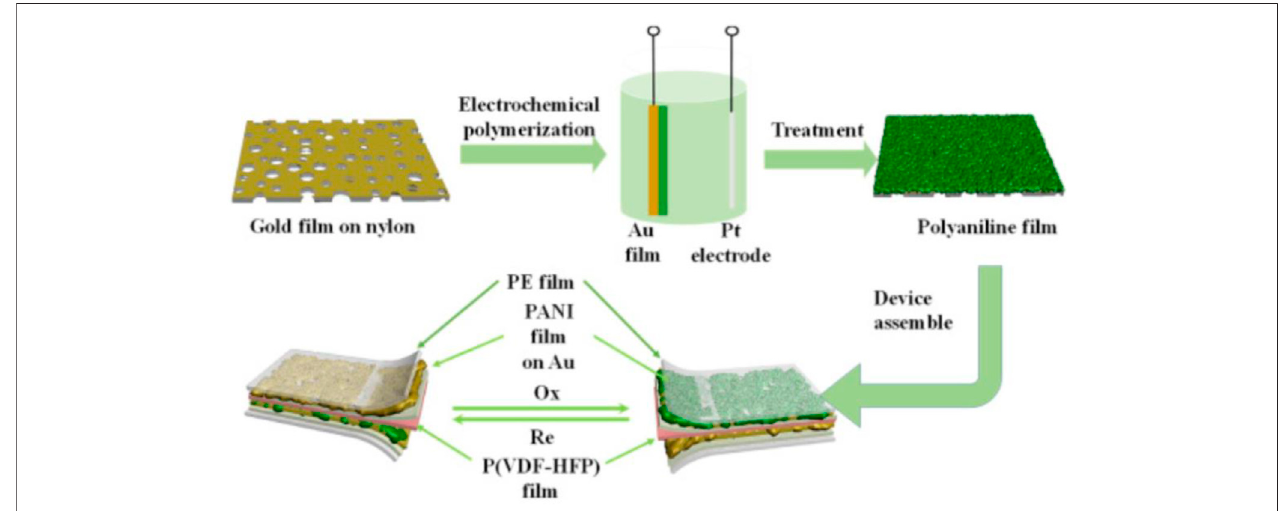
FIGURE 1 | Scheme illustration for the fabrication procedure of a visible-to-infrared broadband fl exible device based on the H 2 SO 4 -doped PANI fi lms. Copy right from Xu et al. (2020a).